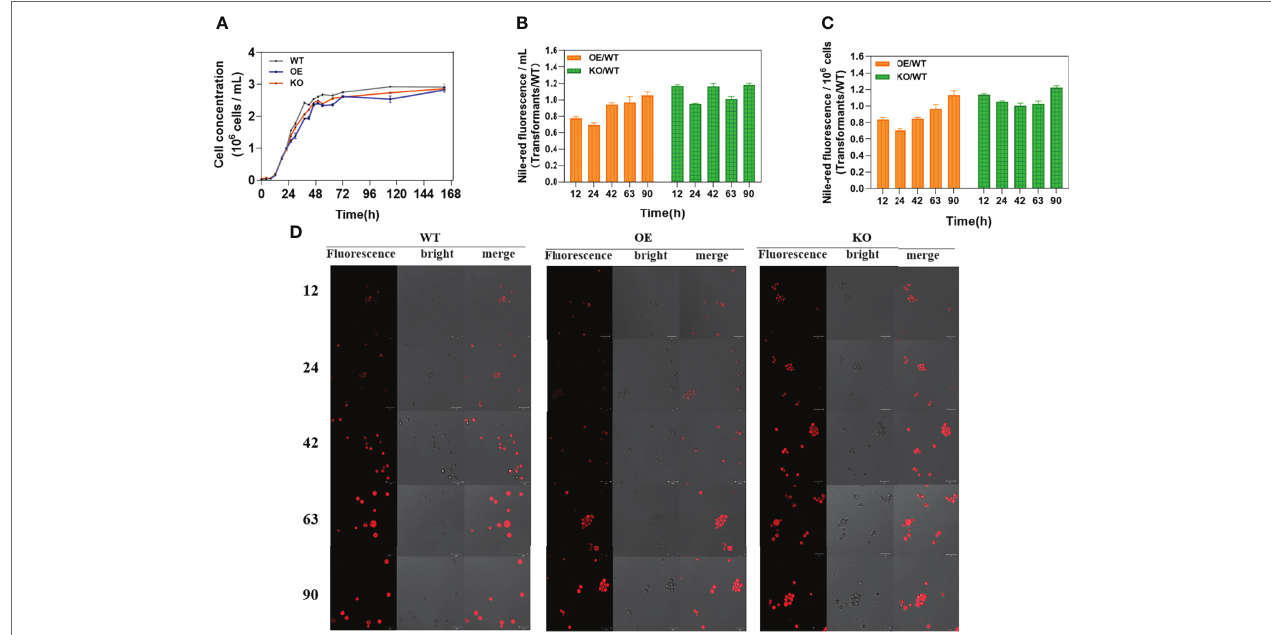
FIGURE 3 | Growth curves and determination of neutral lipids. (A) The growth curves of wildtype (WT) strain, DECR overexpression (OE), and DECR knockout (KO) transformants were determined over a total period of 162 h. (B) Nile red fluorescence ratio of transformants (OE and KO) to wildtype (WT) per milliliters of strain solution. (C) Nile red fluorescence ratio of transformants (OE and KO) to wildtype (WT) per 10 6 cells. (D) Nile red fluorescence observation of wild-type (WT) strain, DECR overexpression (OE), and DECR knockout (KO) transformants in five various periods. All data were collected from three independent experiments. Scale bar: 20 μm. Values are the mean ± standard